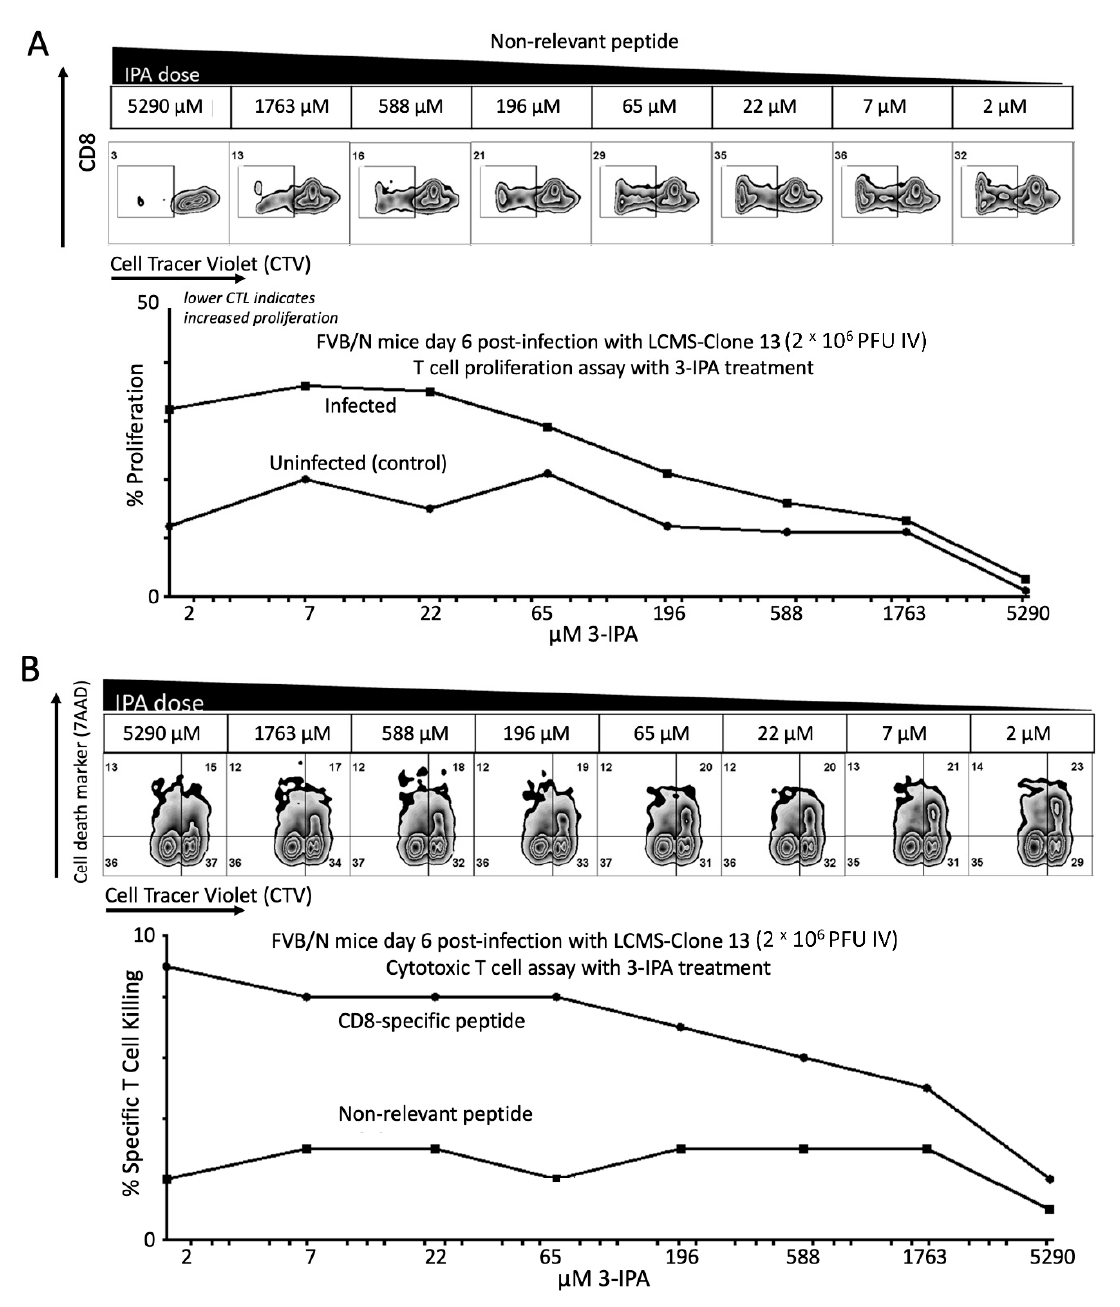
Figure 4. 3-IPA suppresses cytotoxic T-lymphocytes responses. ( A ) 3-IPA dose-dependent suppres- sion of CD8+ T-cell proliferation from infected FVB/N mice with LCMV Cl13 for 6 days. ( B ) 3-IPA dose-dependent suppression of target cell killing by CD8+ T cells from infected FVB/N mice with LCMV Cl13 for 6 days.